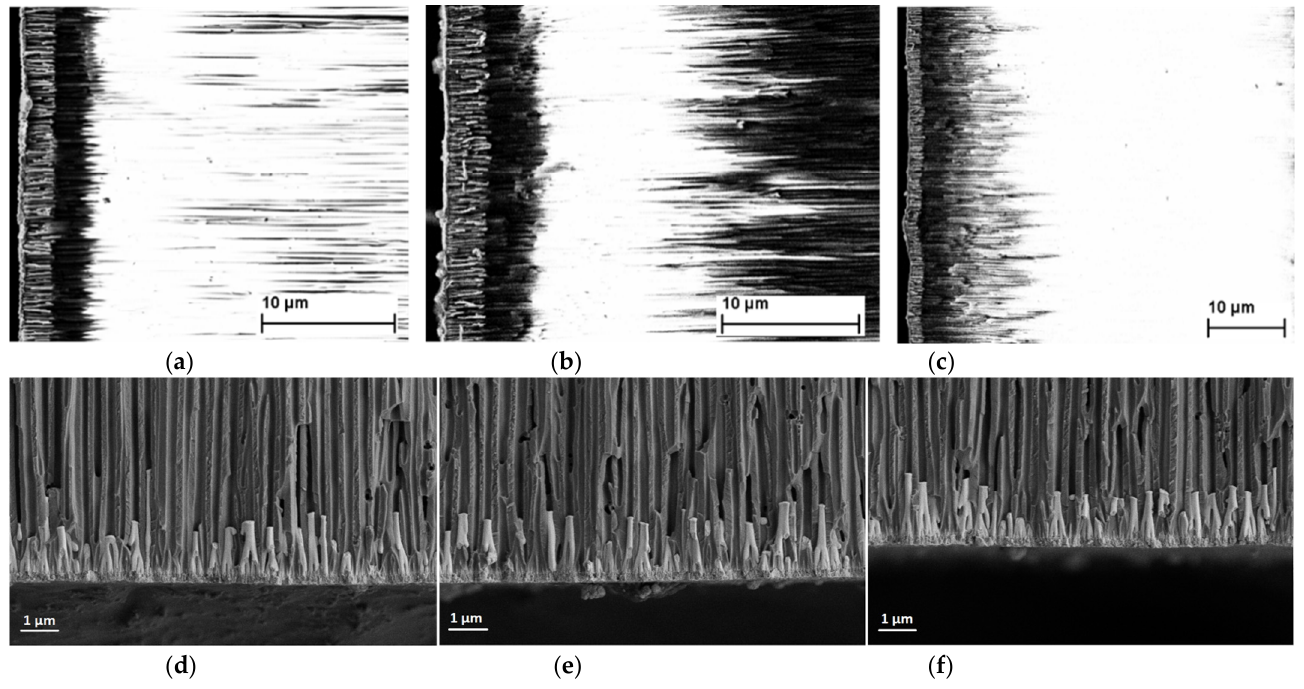
Figure 3. HR-SEM image of the AAO template cross-section filled with electrodeposited MNWs, including ( a , d ) NiFe nanowires, ( b , e ) CoPt nanowires, and ( c , f ) CoFe nanowires. Note: the AAO is dark in SEM along the Debye length (where electrons are conducted to the MNWs), above which it is bright due to charging.